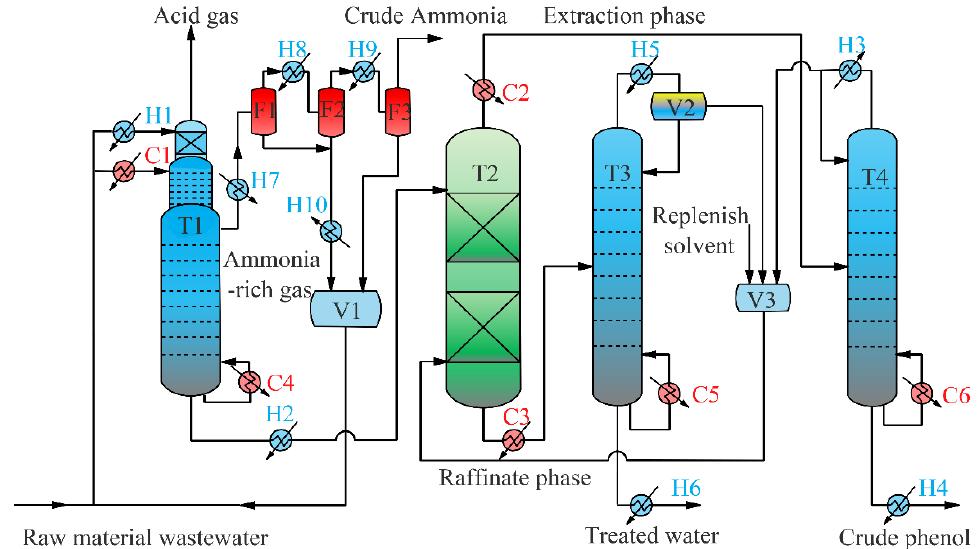
Figure 1. Flow chart of phenols and ammonia recovery process. T1: Sour water stripper; T2: Extraction column; T3: Solvent stripper; T4: Solvent distillation column; F1~3: Flash tanks; V1~3: Storage tanks; H1~10: Cooler; C1~6: Heater.